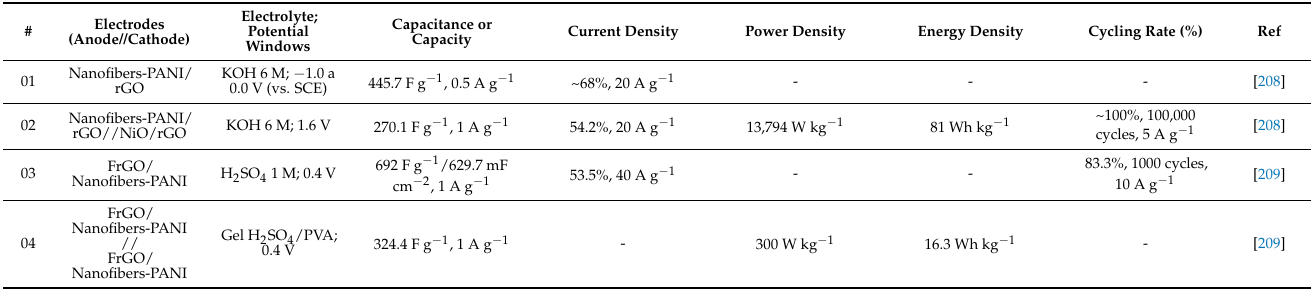
Table 1. Nanostructured PANI, in combination with carbonaceous materials, was evaluated as electrodes for supercapacitors, with their performance